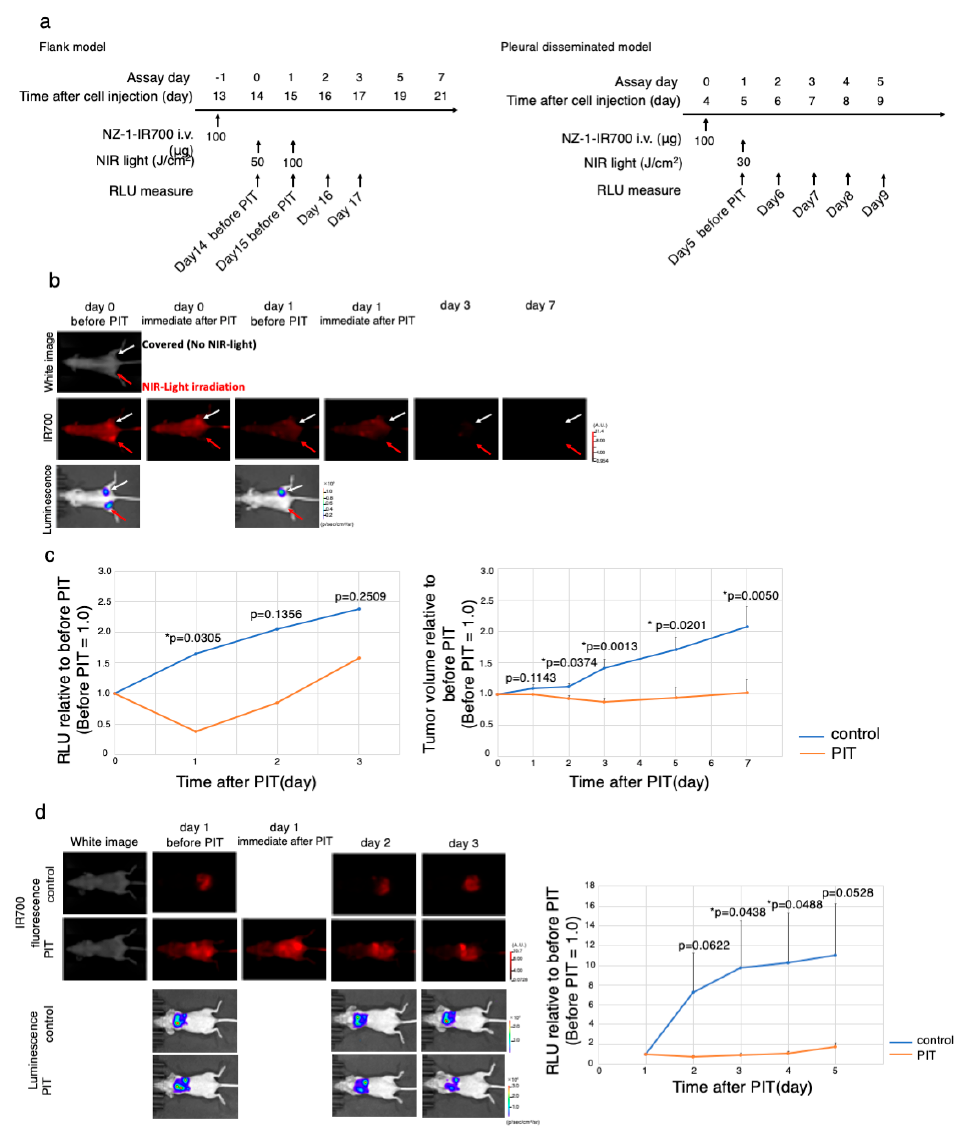
Figure 5. In vivo antitumor effect of PDPN-targeted NIR-PIT. ( a ) The PDPN-targeted NIR-PIT regimen is shown in a line. ( b ) In vivo FLI and BLI of subcutaneous bilateral flank xenografted mice model. Arrow showed tumor site. Red Arrow tumor was treated with NIR-PIT. ( c ) Quantitative RLU demonstrated a significant decrease in PDPN-targeted NIR-PIT-treated tumors (before NIR-PIT = 1) (* p < 0.05 versus control, t -test). PDPN-targeted NIR-PIT also leads to significant reductions in tumor volume (* p < 0.05 versus control, t -test) in a flank model ( n = 4 mice in each group). ( d ) PDPN-targeted NIR-PIT in the pleural disseminated model. FLI and BLI of the pleural disseminated model are shown on the left. Quantitative RLUs showed that PDPN-targeted NIR-PIT led to significant reductions in luciferase activity (* p < 0.05 versus control, t -test, n ≥ 3 mice in each